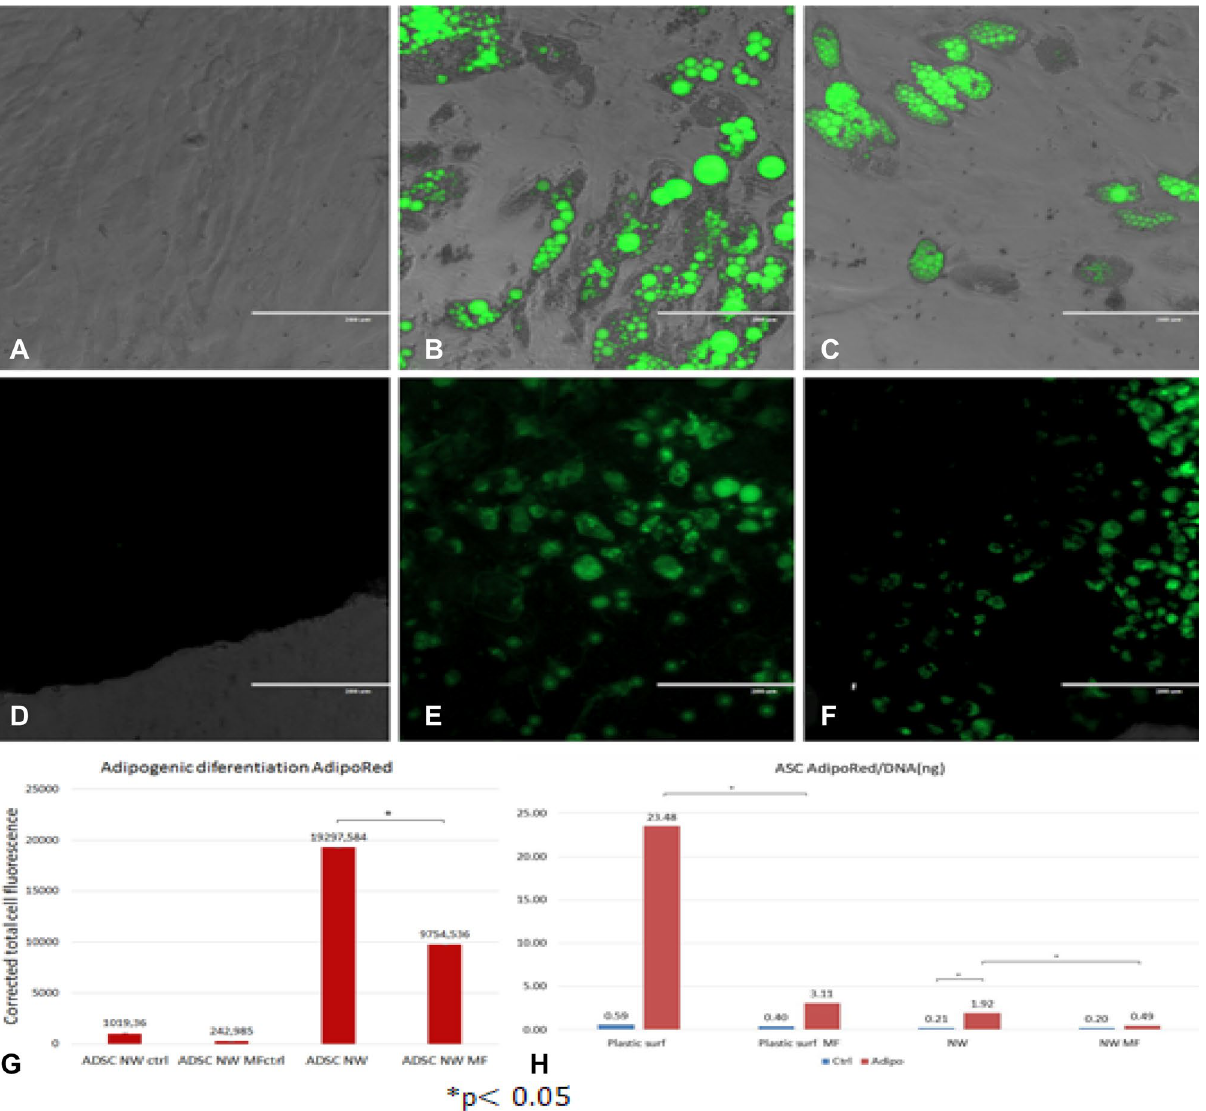
Figure 5. ASCs differentiation: ( A – F ) fluorescence microscope images of adipogenic differentiation: ( A ) control (ASCs on regular adherent culture plates in simple culture media); ( B ) ASCs in regular lates in adipogenic media; ( C ) MF exposed ASCs in adipogenic media; ( D ) ASCs on NW substrate in simple culture media; ( E ) ASCs on NW substrate in adipogenic media; ( F ) ASCs on NW substrate exposed to MF in adipogenic media; AdipoRed ® fluorescent staining of intracellular lipid accumulation, all images represent overlay of transmitted and GFP fluorescence images captured with inverted fluorescent microscope (EVOS Life Sciences); ( G ) semiquantitative assessment of AdipoRed ® fluorescence using Image J software; ( H ) Quantitative assessment of AdipoRed ® fluorescence using spectrophotometric plate reader relative to DNA